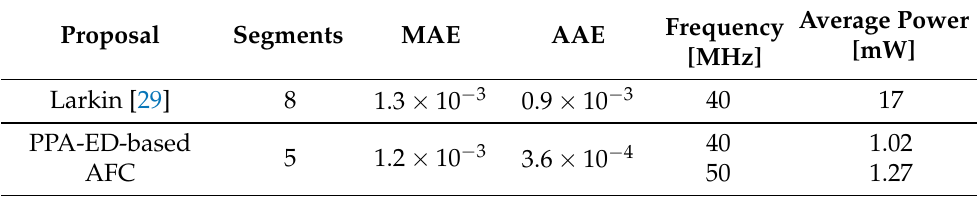
Table 13. Power consumption comparison for Sigmoid AF.